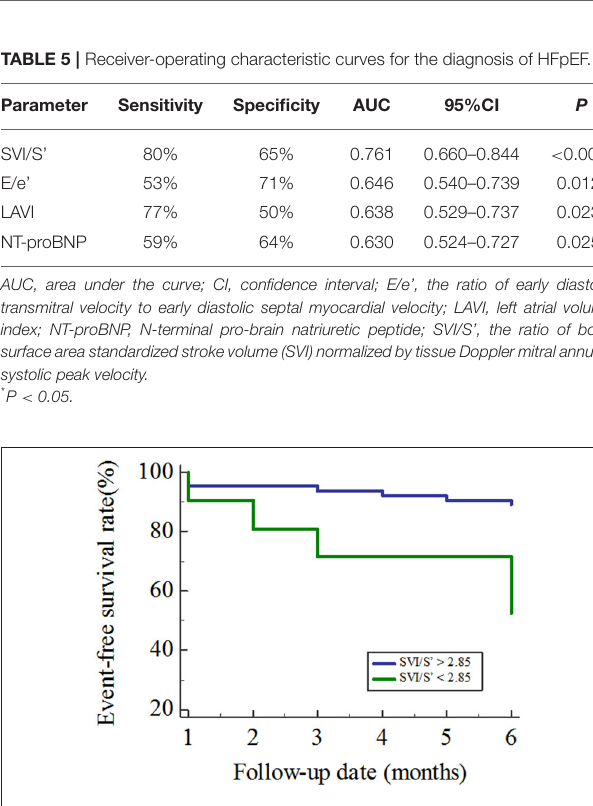
FIGURE 3 | Kaplan–Meier curves for the freedom from the primary outcome. SVI/S’, the ratio of body surface area standardized stroke volume (SVI) and tissue Doppler mitral annulus systolic peak